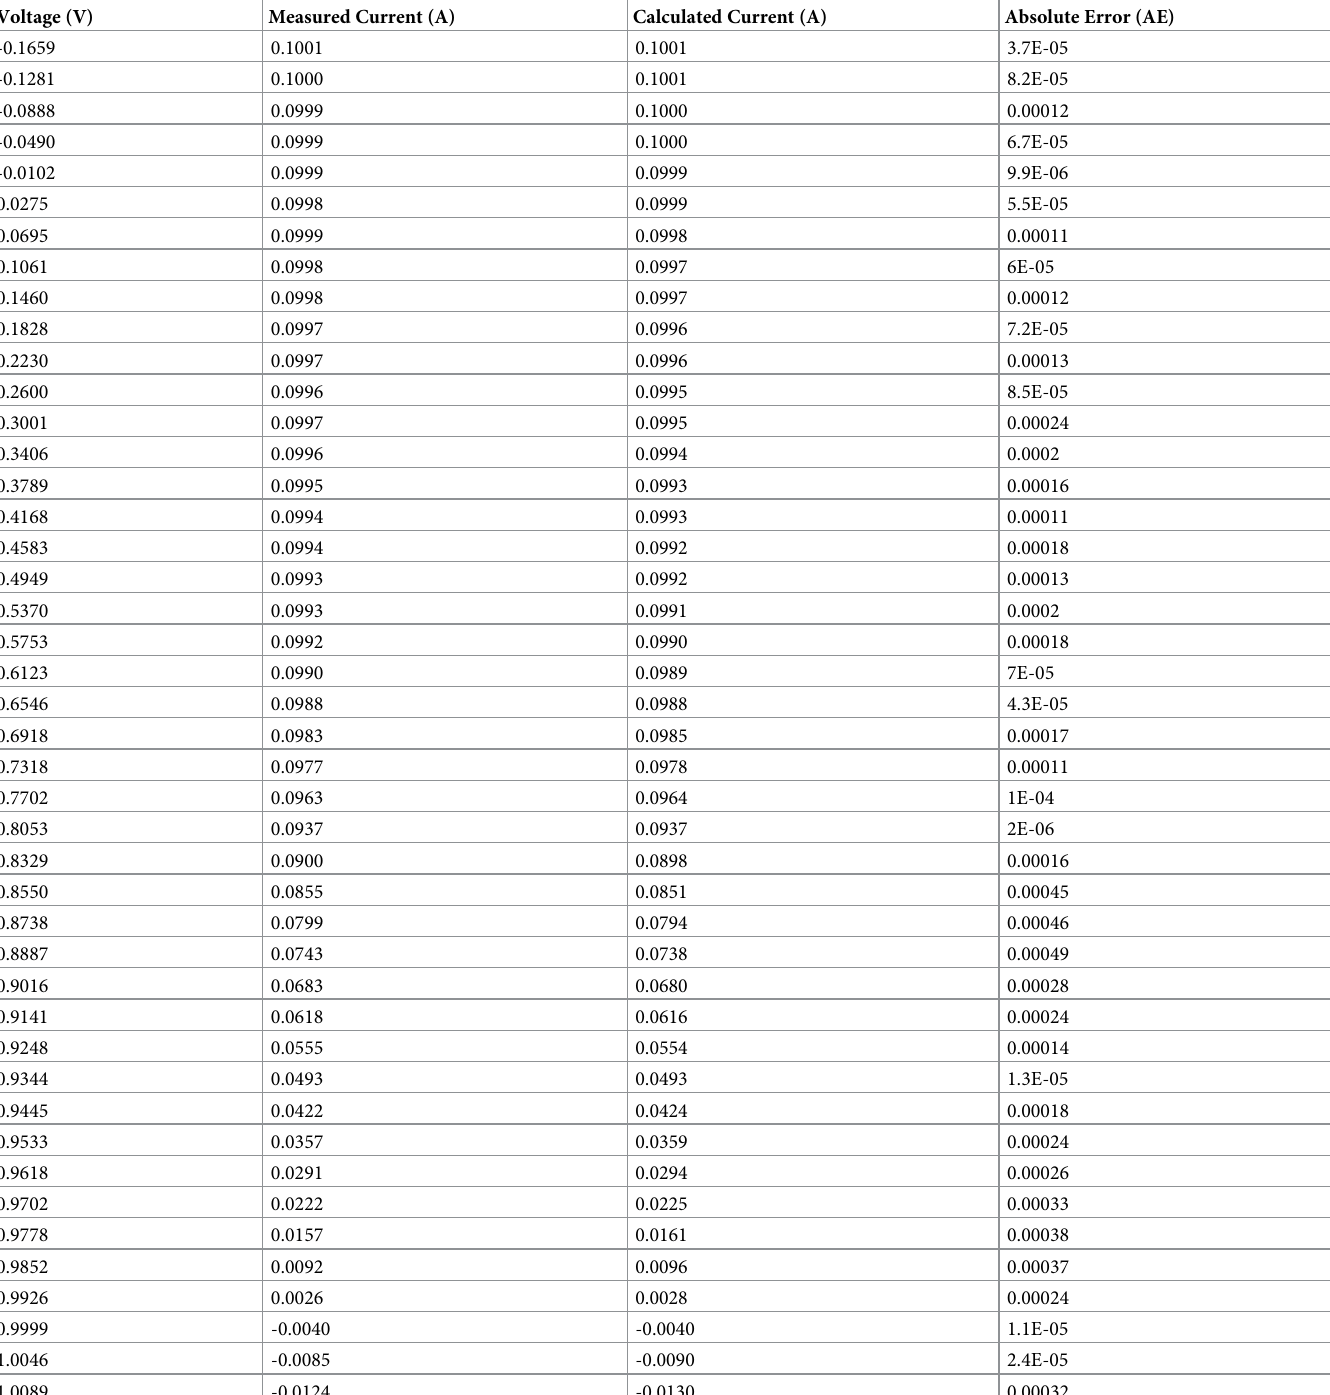
Table 3. Calculated/simulated results for single-diode model of PVM 752 GaAs thin film cell achieved using